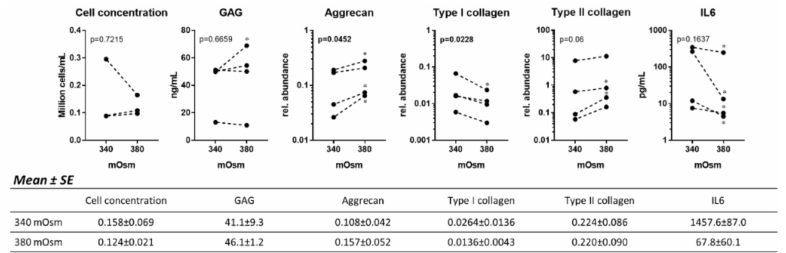
Figure 3. Human OA chondrocytes were cultured for three weeks in alginate at 340 or 380 mOsm. The alginate beads were dissolved, and the cell and GAG content measured in the alginate. Cells were also used to evaluate gene expression of aggrecan, type II and I collagen by qRT-PCR. IL6 was measured in the medium with a cytokine multiplex assay (see Materials and Methods). Data on the graphs represent the mean of technical replicates ( n = 3–6). Statistical analysis was performed for each donor separately (* means significantly di ff erent from 340 mOsm with p < 0.05) and for all donors together with the p values being shown on the graphs ( p values in bold when p ≤ 0.05). The means and standard errors of the mean (SE) for all donors together are tabulated below the graphs.